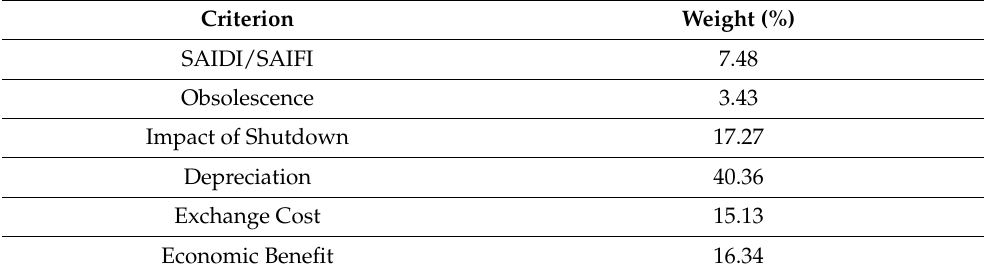
Table 6. Global weights of the AHP model considering default